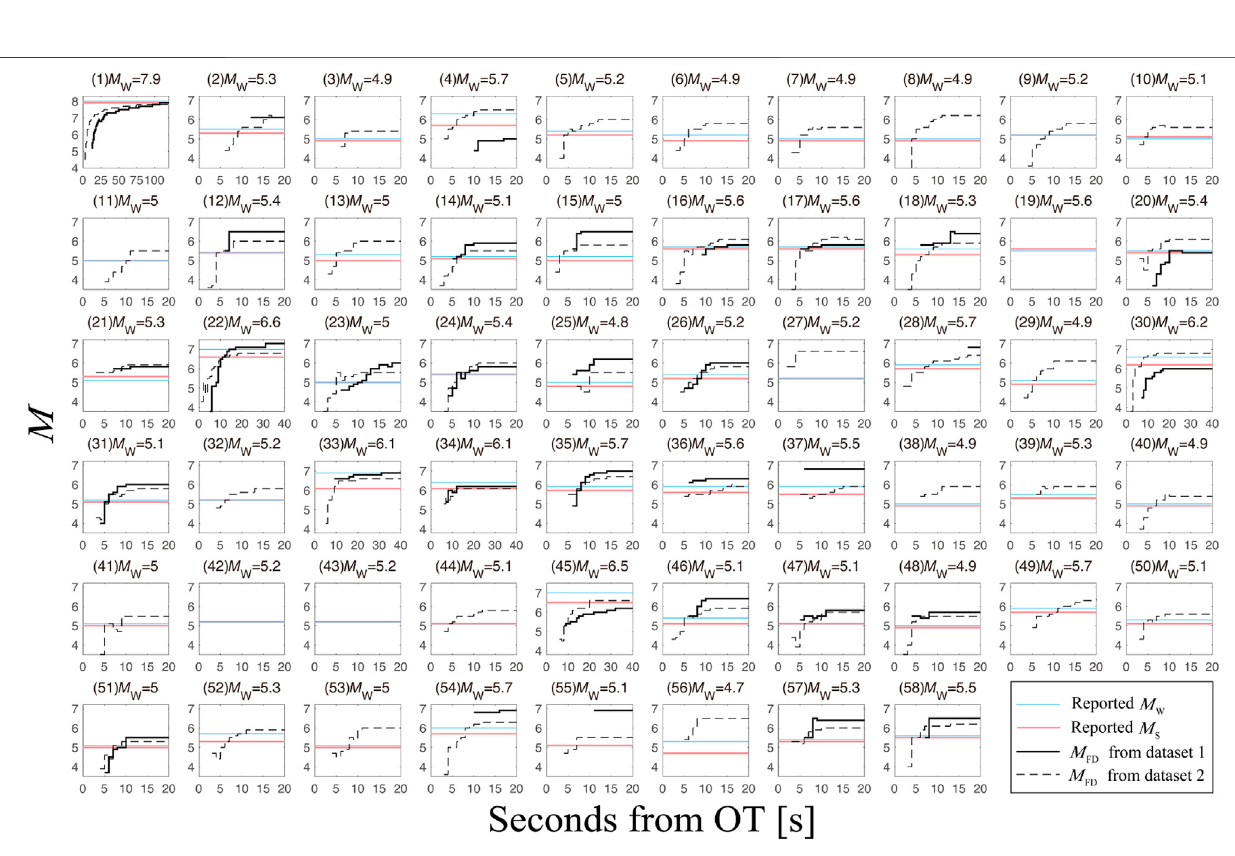
Frontiers in Earth Science |